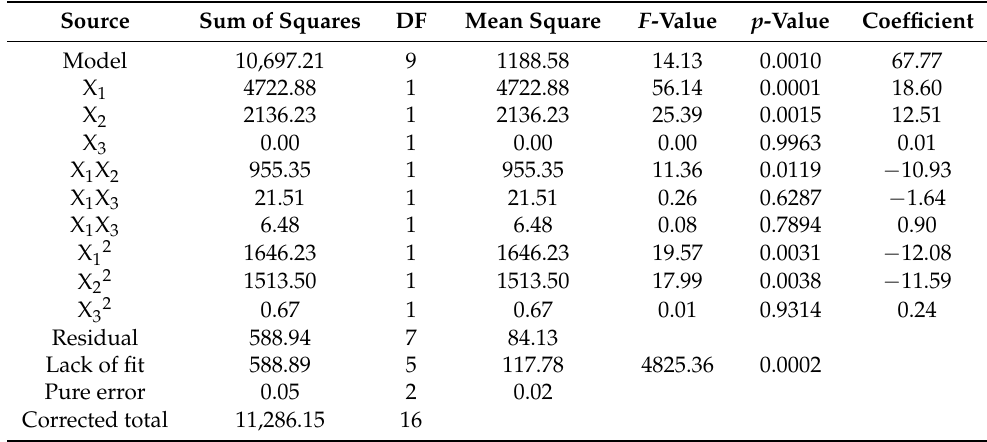
Table 3. Analysis of variance (ANOVA) for furfural yield in dehydration of xylose model compound and coefficients for quadratic